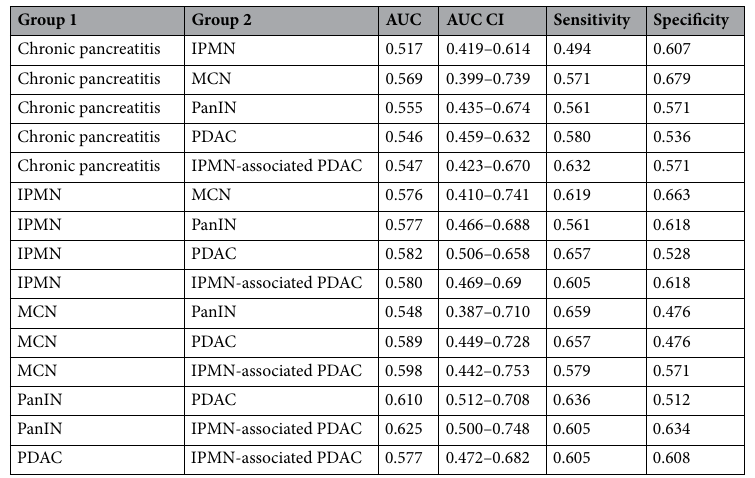
Table 4. Image-wise classification results between the six pancreatic diseases using the Morisita-Horn Index. The rows highlighted in bold indicate classification AUCs that are identified as significant, with 0.75 selected as the threshold value for significance.This value was determined after analysing the results as a whole and on consultation with the physician. No row was highlighted in this case, as no AUC value was above the 0.75 threshold